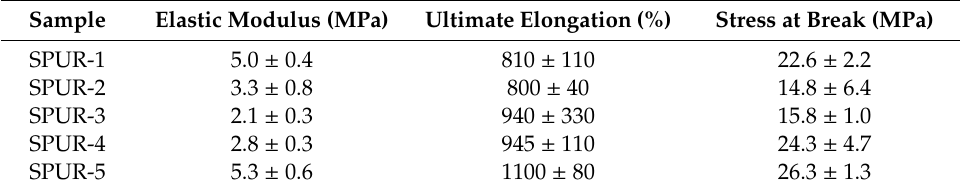
Table 4. Uniaxial tensile mechanical properties of